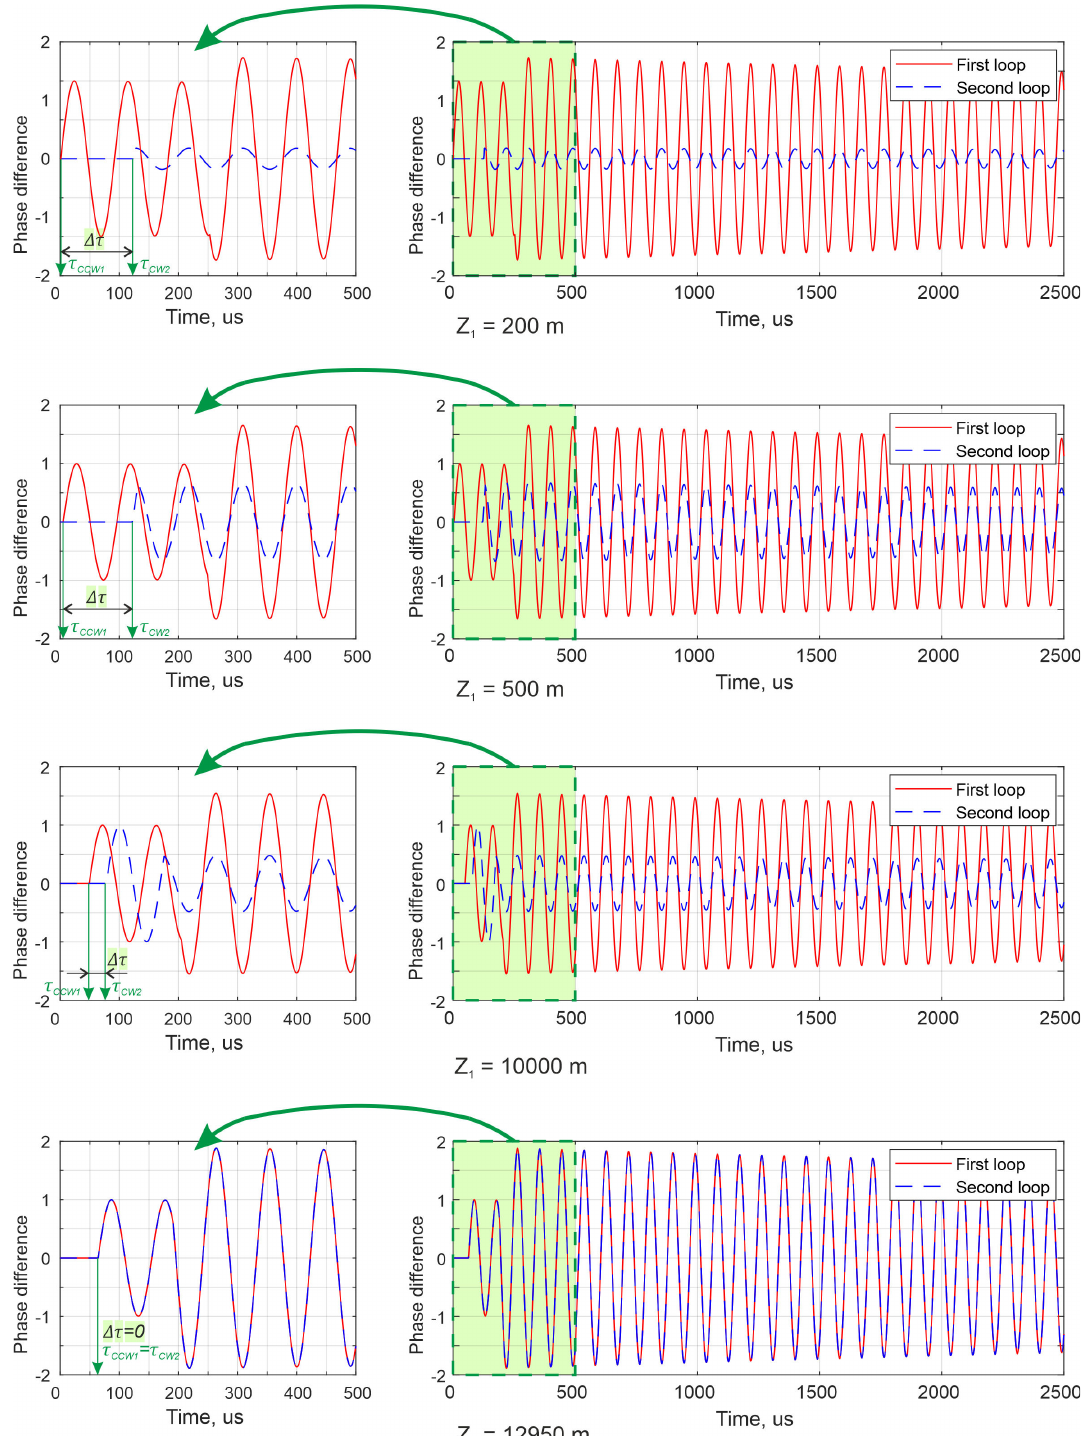
Figure 10. Simulated signal plots for two